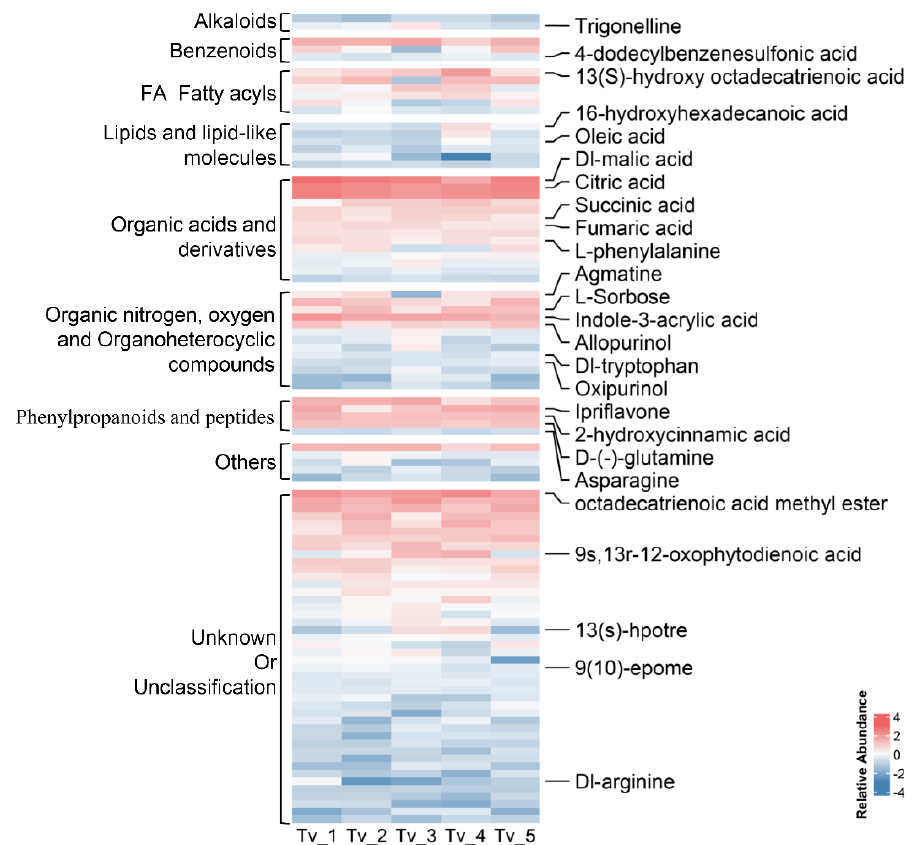
Figure 5. Untargeted metabolic profiling of T. virens 192 ‐ 45 with the top 100 metabolites of high abundance from peak area.